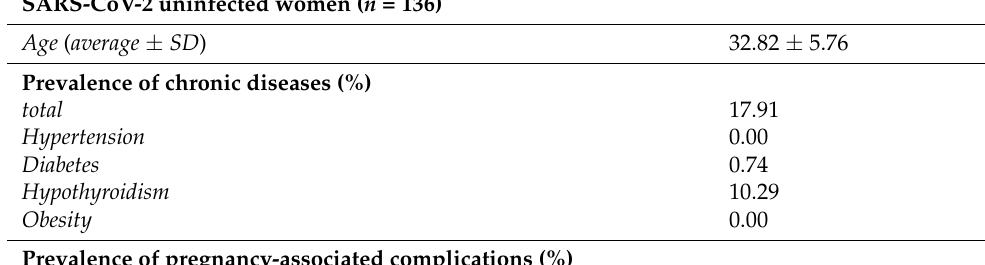
Table 2. General characteristics of SARS-CoV-2-uninfected pregnant women enrolled in the study and their